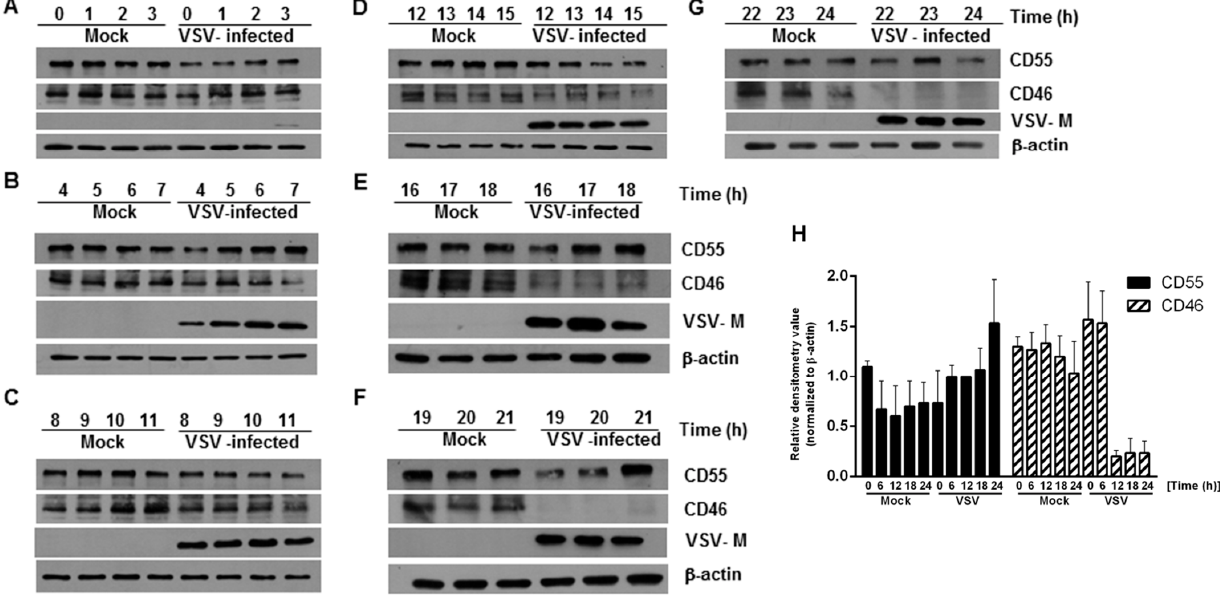
Figure 1. Levels of complement-regulatory protein CD55 remain unaltered, but CD46 levels decline in HeLa cells infected with vesicular stomatitis virus. ( A – G ) Whole cell lysates collected from mock- and VSV-infected HeLa cells at the indicated time points were subjected to immunoblotting to determine the expression of CD46 and CD55. Samples at the time point 0–3 h ( A ), 4–7 h ( B ), 8–11 h ( C ), 12–15 h ( D ), 16–18 h ( E ), 19–21 h ( F ) and 22–24 h ( G ), respectively. Anti-CD55 and CD46 antibodies were used to detect the levels of the corresponding proteins in the lysate at different time points. Virus infectivity was detected using a VSV anti-M antibody while actin served as the loading control. The levels of CD55 were maintained at all of the time points tested compared to the mock; however, the levels of CD46 declined significantly, starting from 15 h onwards (note the decreasing levels of CD46 in D , E , and the complete absence in F , G ). The entire panel of blots is representative of three independent experiments. ( H ) The densitometry analysis of the CD55 and CD46 protein expression, normalized against the loading control. The data represents the mean + SEM of the three independent